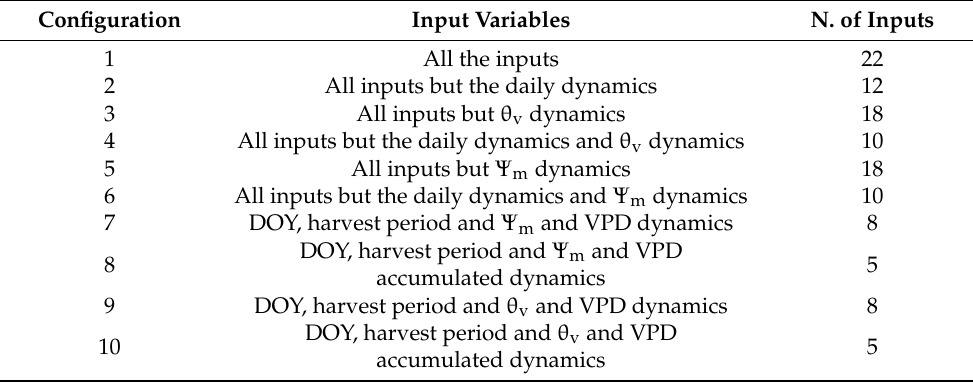
Table 3. Model input configurations